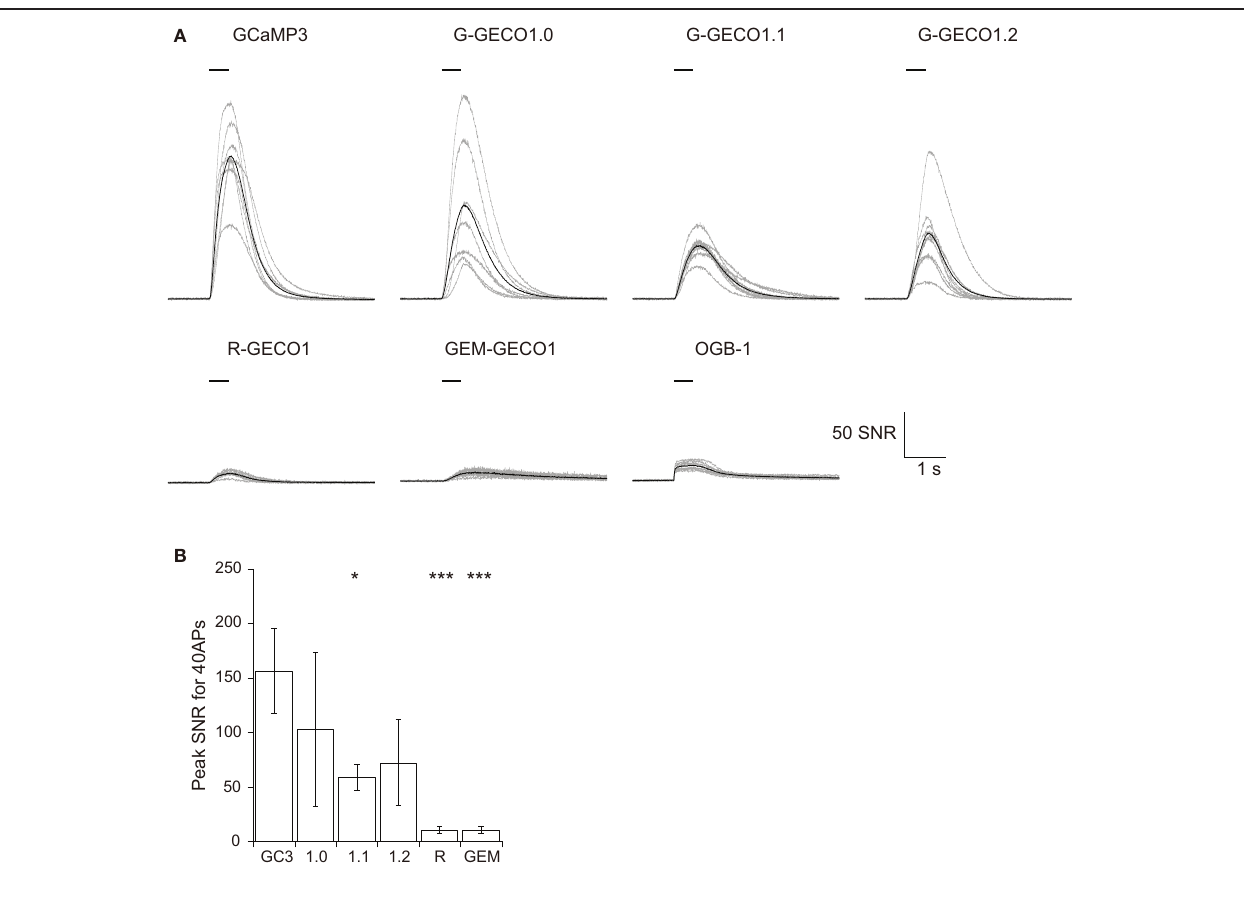
FIGURE 3 | Responses of GCaMP3, GECOs, and OGB-1 to 40 APs evoked at 83Hz. (A) SNR traces in response to 40APs evoked at 83Hz. Gray traces are from individual cells and black traces represent the mean across cells ( n = 8 for GCaMP3, R-GECO1, and OGB-1, n = 7 for G-GECO1.0, and n = 9